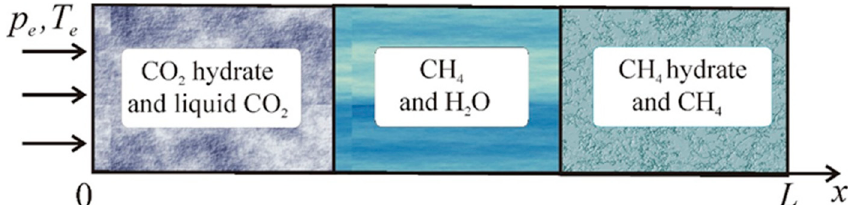
Figure 2. Methane hydrate decomposition is present only between the 2 and 3 boundaries, respectively, on the moving frontal surface. In this case, the formation of CO 2 hydrate occurs only at the border between 1 and 2 regions. Mathematics 2020 , 8 , x FOR PEER REVIEW